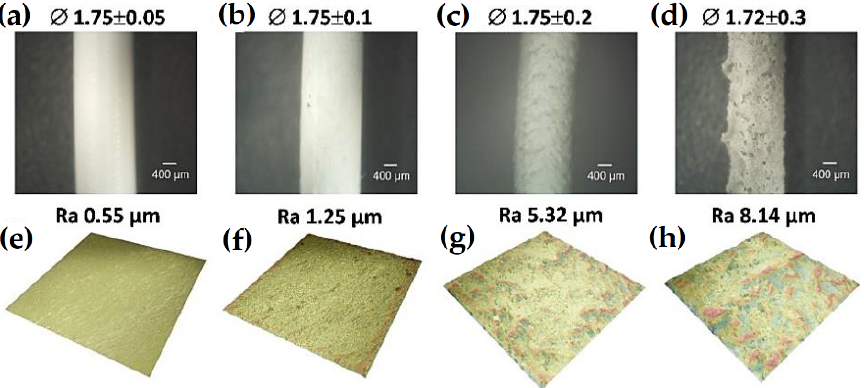
Figure 14. Optical photographs, diameter ( ∅ ), surface topography and measured roughness ( Ra ) of commercial polylactide ( a , e ), 50Al 2 O 3 /50PLA ( b , f ), 60Al 2 O 3 /40PLA ( c , g ) and 70Al 2 O 3 /30PLA ( d,h ) of the studied filaments.